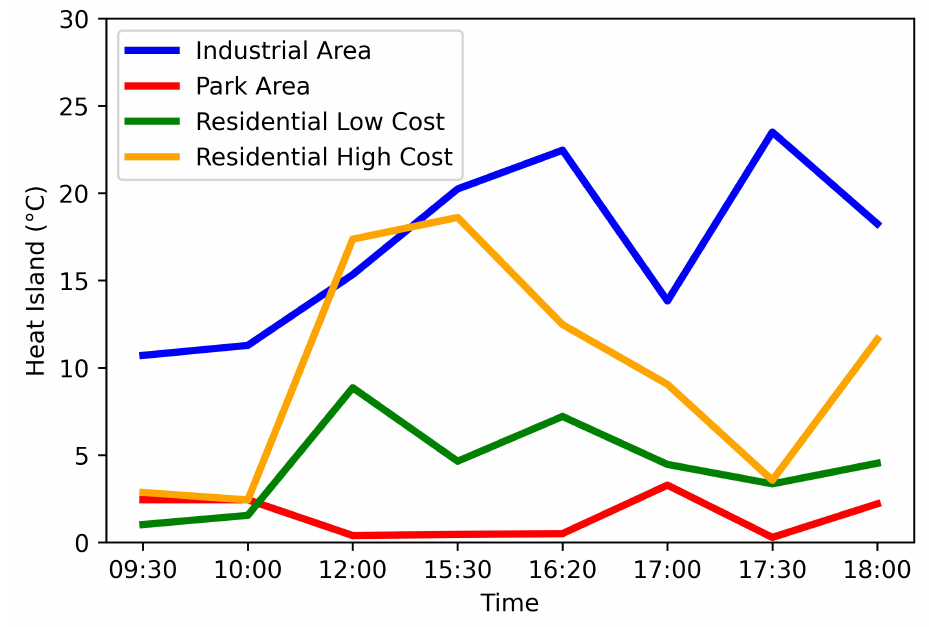
Figure 8. Temporal variation of heat island in each